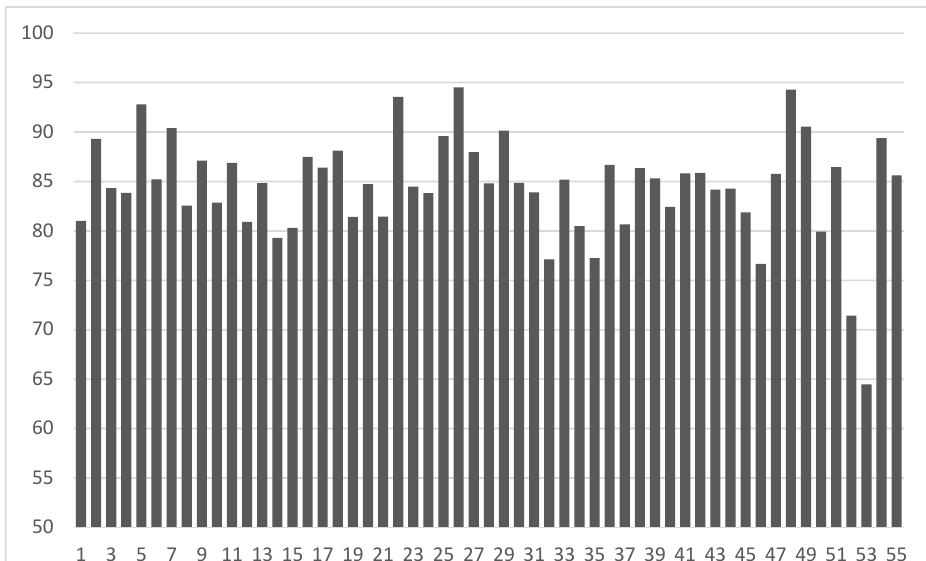
Figure 3. Classification accuracy ( y -axis) of the elderly and young adults for 55 behaviors ( x -axis).